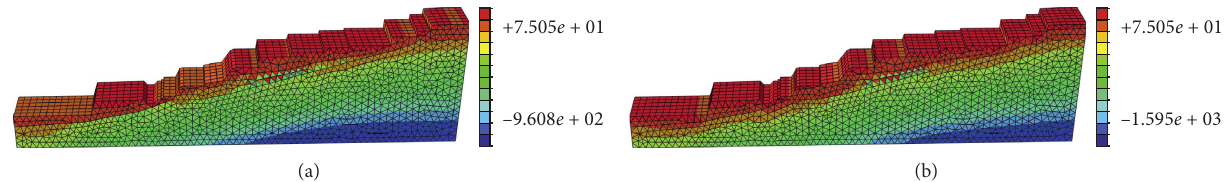
Figure 11: The stress contour map under critical damage condition. (a) Horizontal stress. (b) Vertical